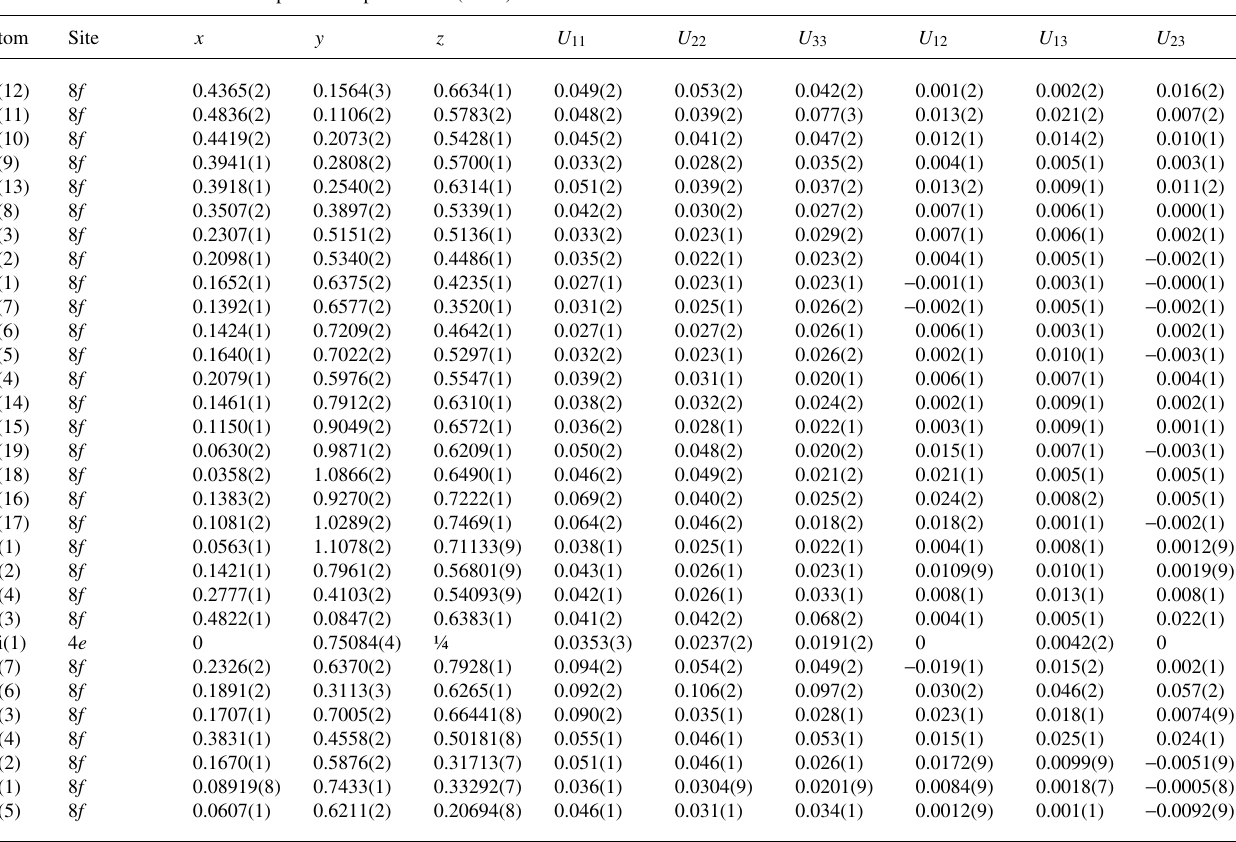
Table 3. Atomic coordinates and displacement parameters (in Å 2 ) .